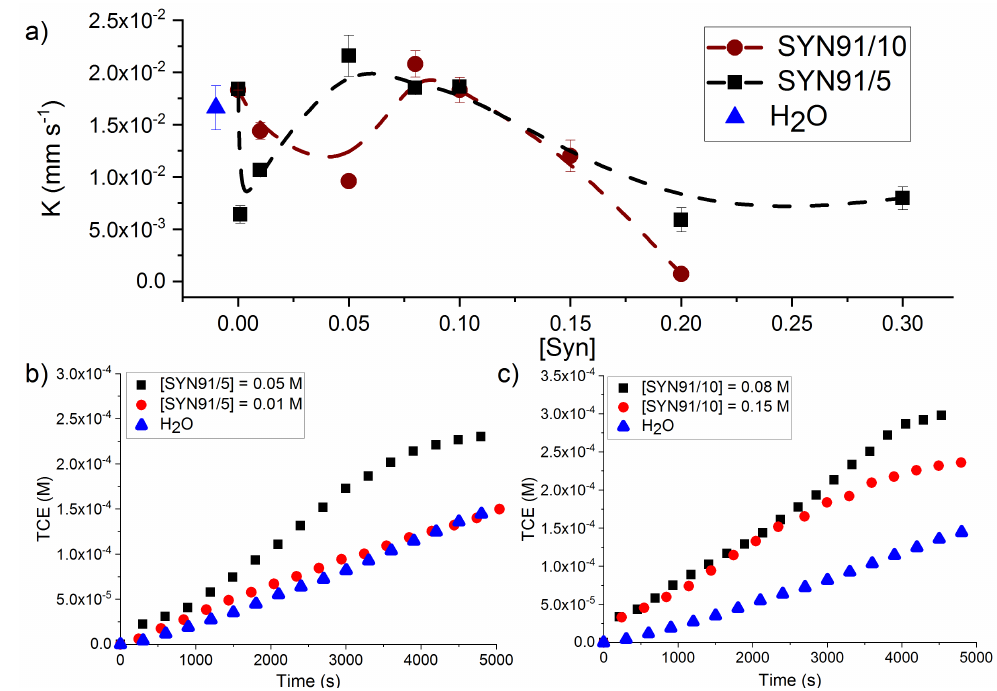
Figure 5. ( a ) Trend of K in the presence of surfactants in the bulk compared with mass transfer rate in pure water. Lines are guides for the eye; ( b , c ) dissolution dynamics of a TCE droplet in the presence and in the absence of surfactants for SYN91/5 and SYN91/10,